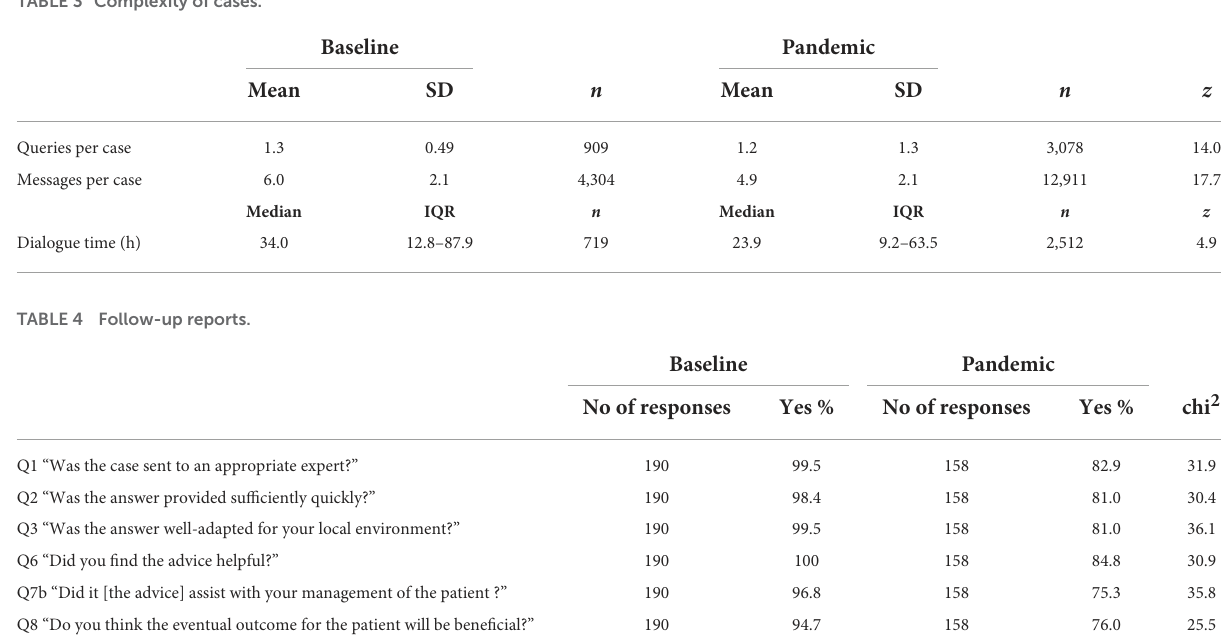
TABLE 3 Complexity of